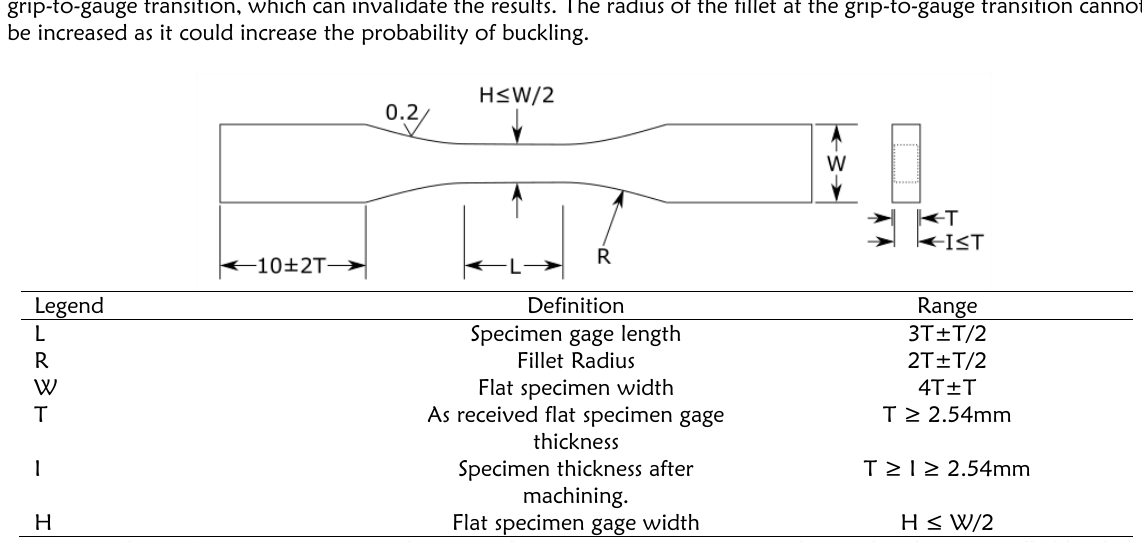
Figure 5: The ASTM E606 specimen with rectangular cross section. Specimen is designed with tangentially blended fillets between the clamping section and the gauge length.